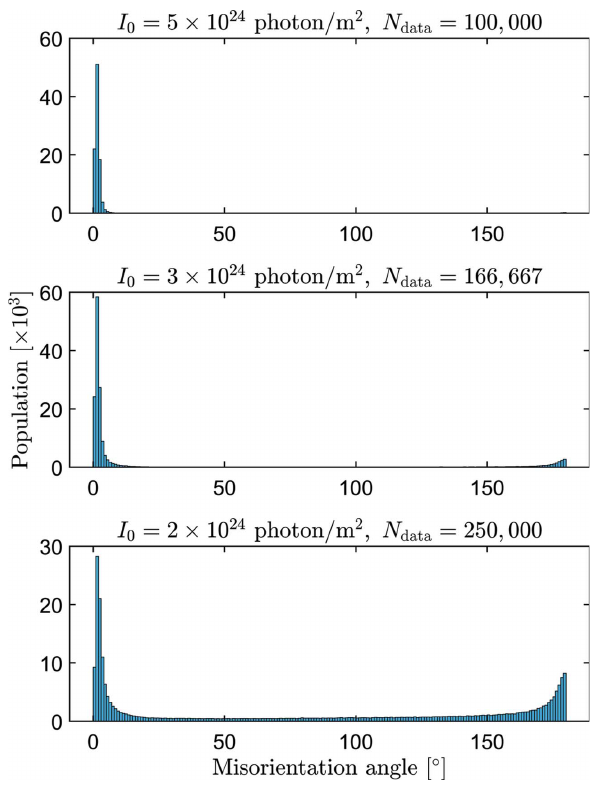
Figure 10 Distribution of the misorientation angle for the same pulse fluences as in Fig. 9, but using different numbers of diffraction patterns. The numbers of patterns N data (indicated at the top of the panels) are chosen to keep the total number of collected photons constant. The histogram in the top panel is identical to that of Fig. 9, we included it here for easier